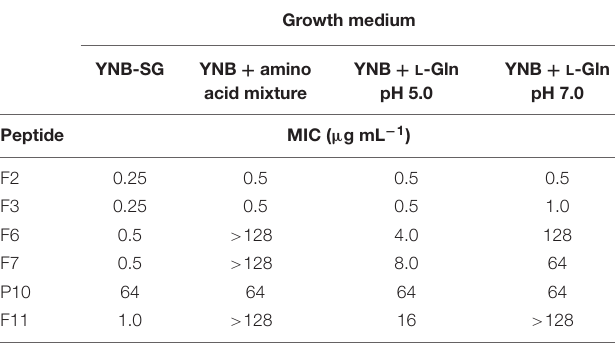
TABLE 6 | Influence of supplementation of the YNB medium with the amino acid mixture (composition as in RPMI-1640) or L -glutamine (0.3 g L − 1 ) on anticandidal in vitro activity.